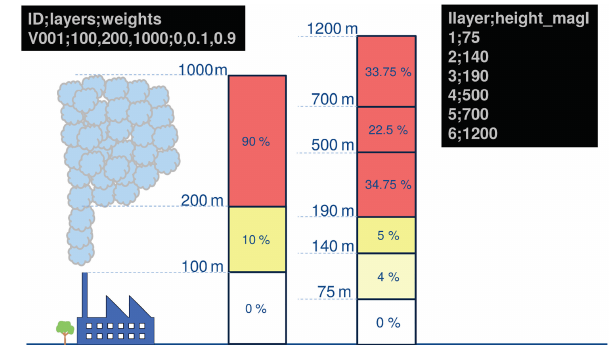
Figure 4. Schematic representation of the emission vertical dis- tribution process implemented within HERMESv3_GR. Left side shows an example of a vertical profile description (“V001”), which allocates 10% of emissions between 100 and 200ma.g.l. and the remaining 90% between 200 and 1000ma.g.l. Right side shows an example of the vertical description of the domain. Original vertical weights are interpolated to the model vertical layers according to their